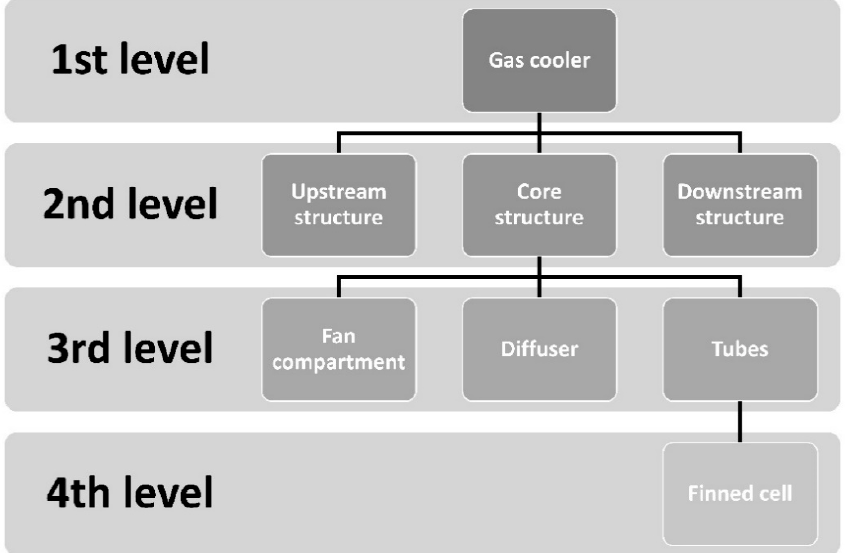
Figure 2. Schematic of the Top-Down approach used for the development of the numerical model. The gas cooler represents the whole system, whose performance is evaluated by solving thermodynamic equations of each basic computational element, represented by the finned cell.